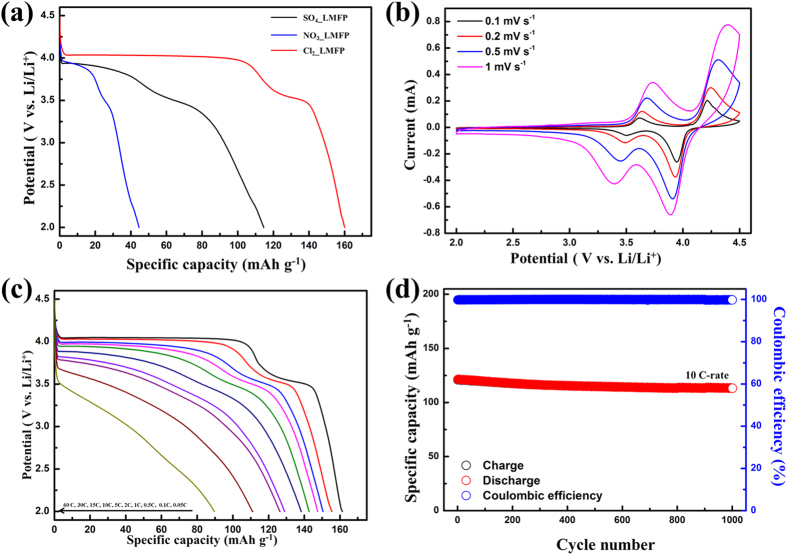
(a) Galvanostatic discharge curves of the LiMn0.75Fe0.25PO4/rGO microspheres synthesized using the different metal salts at 0.05 C. (b) Cyclic voltammograms of Cl2_LMFP obtained at scan rates of 0.1, 0.2, 0.5, and 1.0 mV s−1. (c) Galvanostatic discharge curves of Cl2_LMFP obtained at current rates of 0.05–60 C-rate. (d) Long-term cyclability of Cl2_LMFP at 10 C-rate.